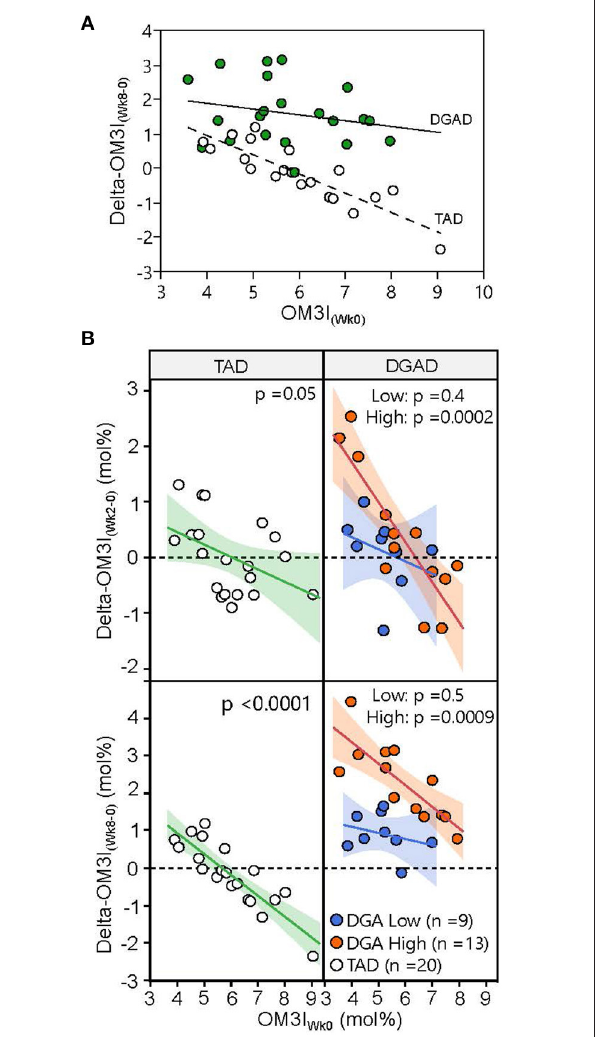
FIGURE 3 | Variance in omega-3 index response to typical American diet (TAD) and Dietary Guidelines for American’s diet (DGAD) interventions. (A) The 8 wk OM3I change (OM3I (Wk8 − Wk0) ) expressed as a function of baseline omega 3 index (OM3I (Wk0) ). Diet ( p < 0.0001), OM3I (Wk0) ( p = 0.0003), and diet x OM3I (Wk0) interactions ( p = 0.036) were detected. (B) Participants within diet groups were clustered according to their OM3I (Wk8 − 0) :OM3I (Wk0) ratio by hierarchical cluster analysis and projected onto both 2 wk (top) and 8 wk (bottom) data. Hierarchical cluster analysis identified low (blue) and high (orange) responding subgroups in the DGAD group. The correlations between OM3I (Wk0) and magnitude of change were significant in the DGAD high, but not low response subgroups.